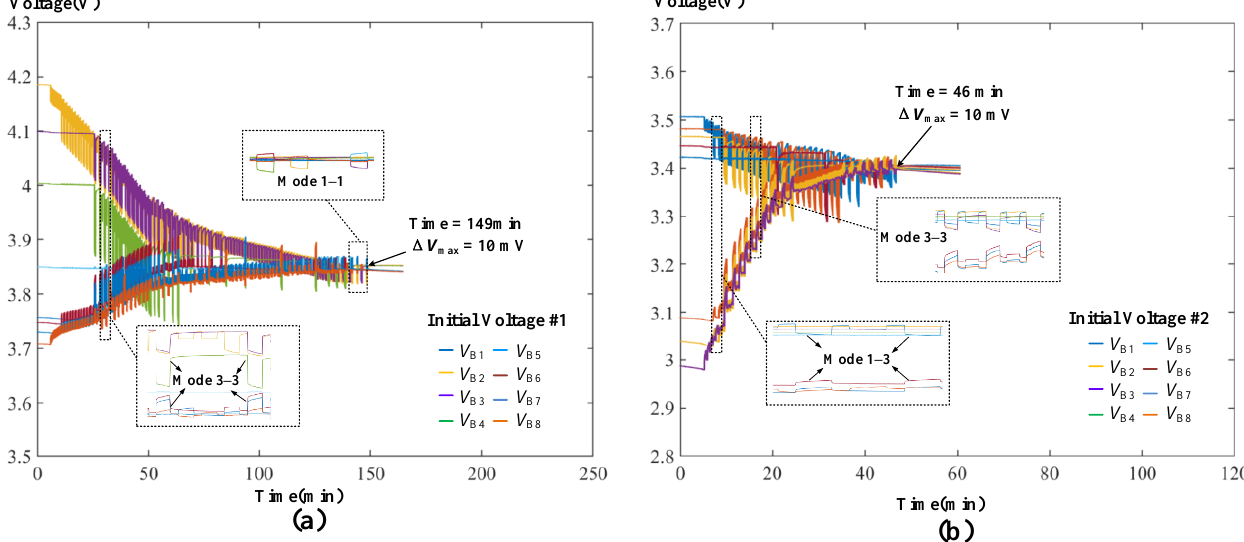
Figure 10. Experimental voltage trajectories of the proposed FBBRLCC equalizer with initial voltage #1 and #2. ( a ) Initial voltage #1; ( b ) initial voltage #2.